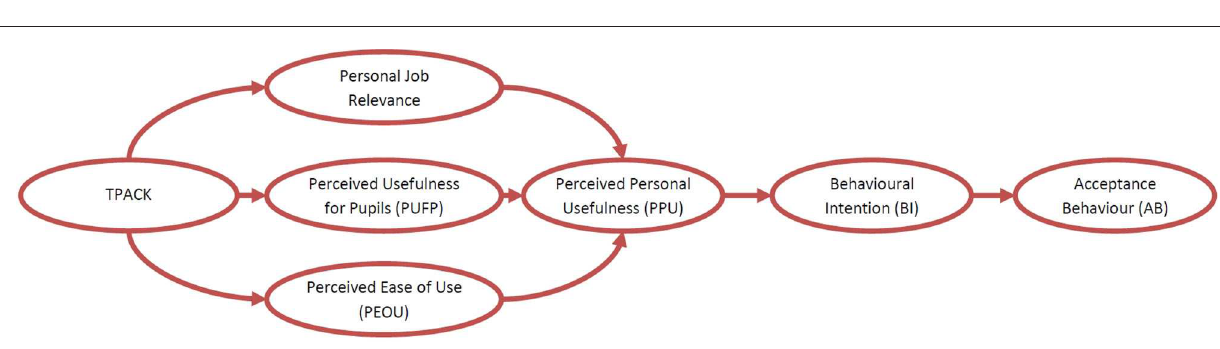
FIGURE 5 | Results of the statistical model calculation of the extended UTAUT model.